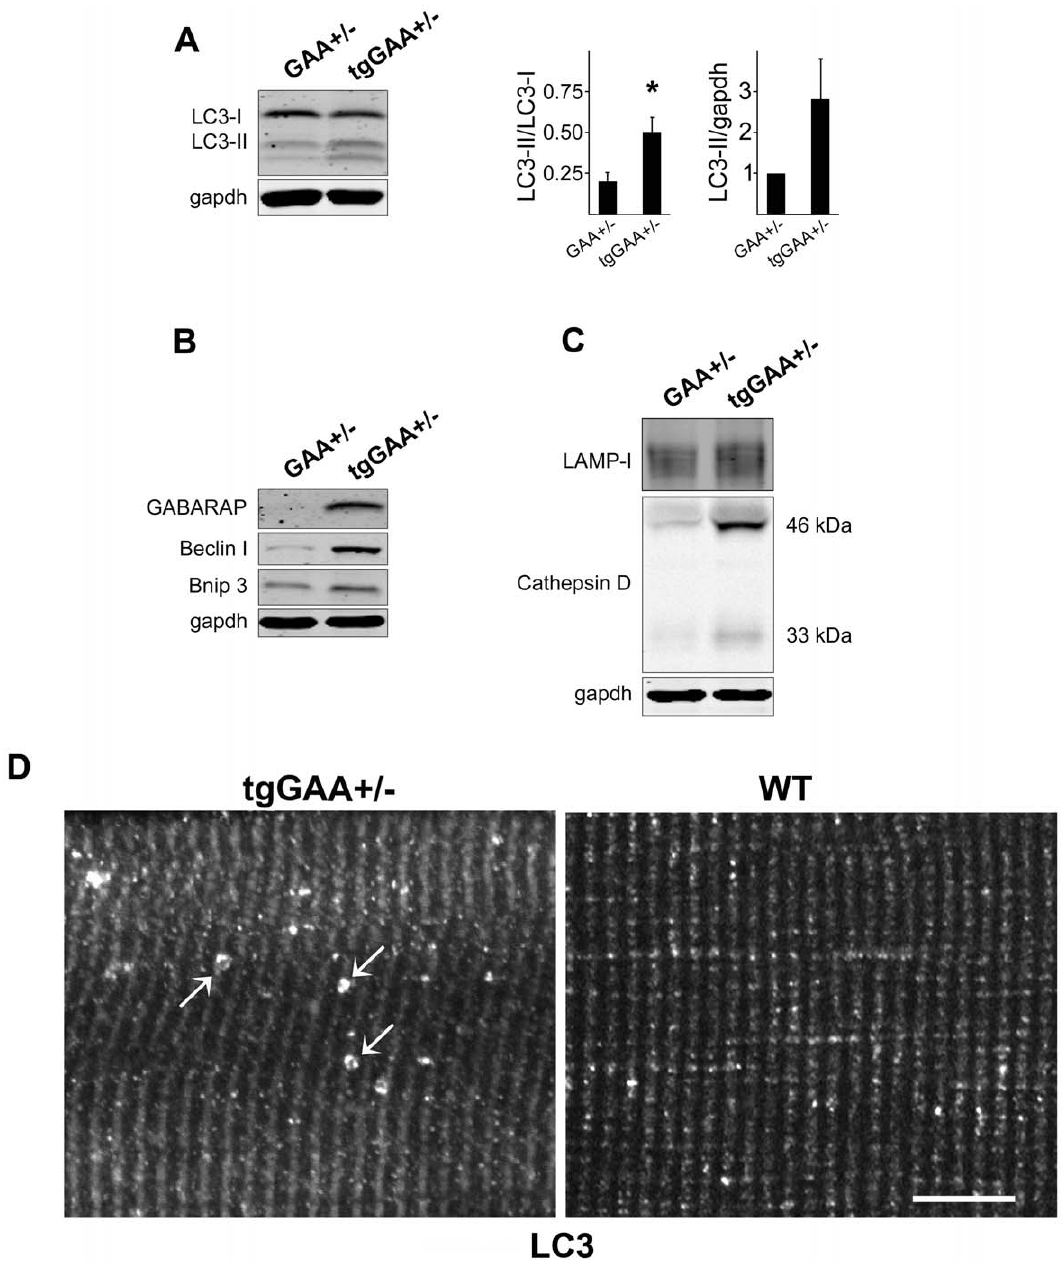
Figure 4. Induction of autophagosomal and lysosomal biogenesis in control PGC-1 a transgenic mice. ( a ) . Western blotting of protein lysates from gastrocnemius (fast) muscles from control GAA + / 2 and tgGAA + / 2 mice with LC3 antibody. The effect of the transgene on autophagy was assessed as an increase in the LC3-II/LC3-I ratio (left graph; * p , 0.005), and as a fold increase of LC3-II/gapdh ratio (right graph) in the transgenic compared to non-transgenic controls. Four mice were analyzed in each group. Note the batch of LC3 antibodies used for these experiments resulted in the appearance of an additional lower band. ( b ) Western blotting of protein lysates from gastrocnemius (fast) muscles from control GAA + / 2 and tgGAA + / 2 mice with the indicated antibodies showing increased levels of autophagy-related proteins – GABARAP, Beclin-1, and Bnip3. ( c ). Western blotting of protein lysates from gastrocnemius (fast) muscles from control GAA + / 2 and tgGAA + / 2 mice with LAMP-1 and cathepsin D antibodies showing increased levels of two lysosomal proteins. Note that cathepsin D runs as two bands of 46 and 33 kDa. Four mice were analyzed in each group. ( d ) Single fibers (type II; psoas) from tgGAA + / 2 and WT mice stained for LC3 (the image is shown in black and white). LC3-positive vesicular structures (arrows) represent autophagosomes. Structures like these are never seen in WT or GAA + / 2 muscles. Bar: 10 m m.